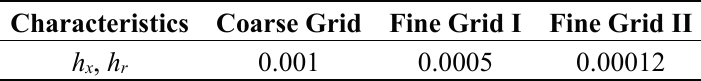
Table 6. Using difference